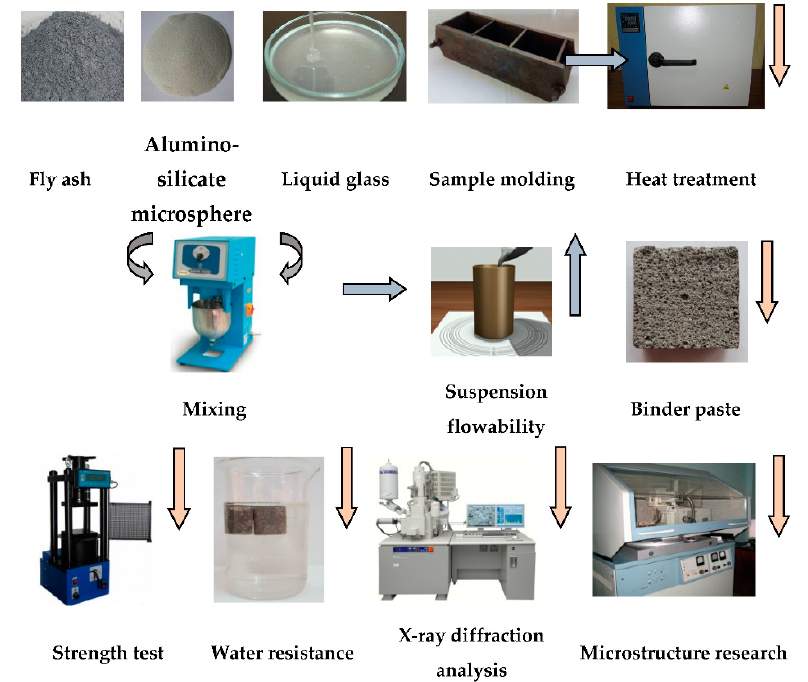
Figure 4. Flowchart of research of liquid glass binder.